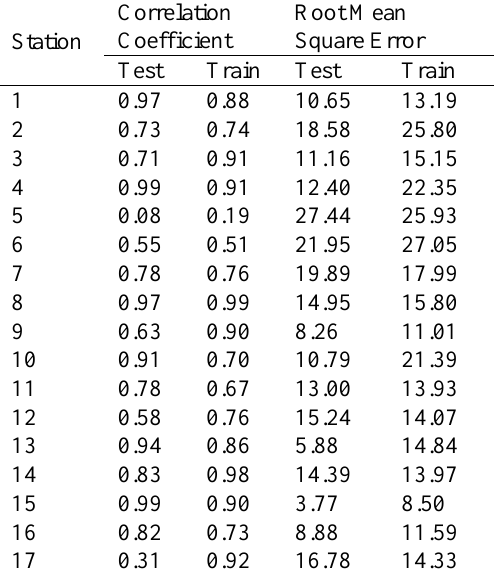
Table 4. The results of the study and verification CARMA model in modeling the values of